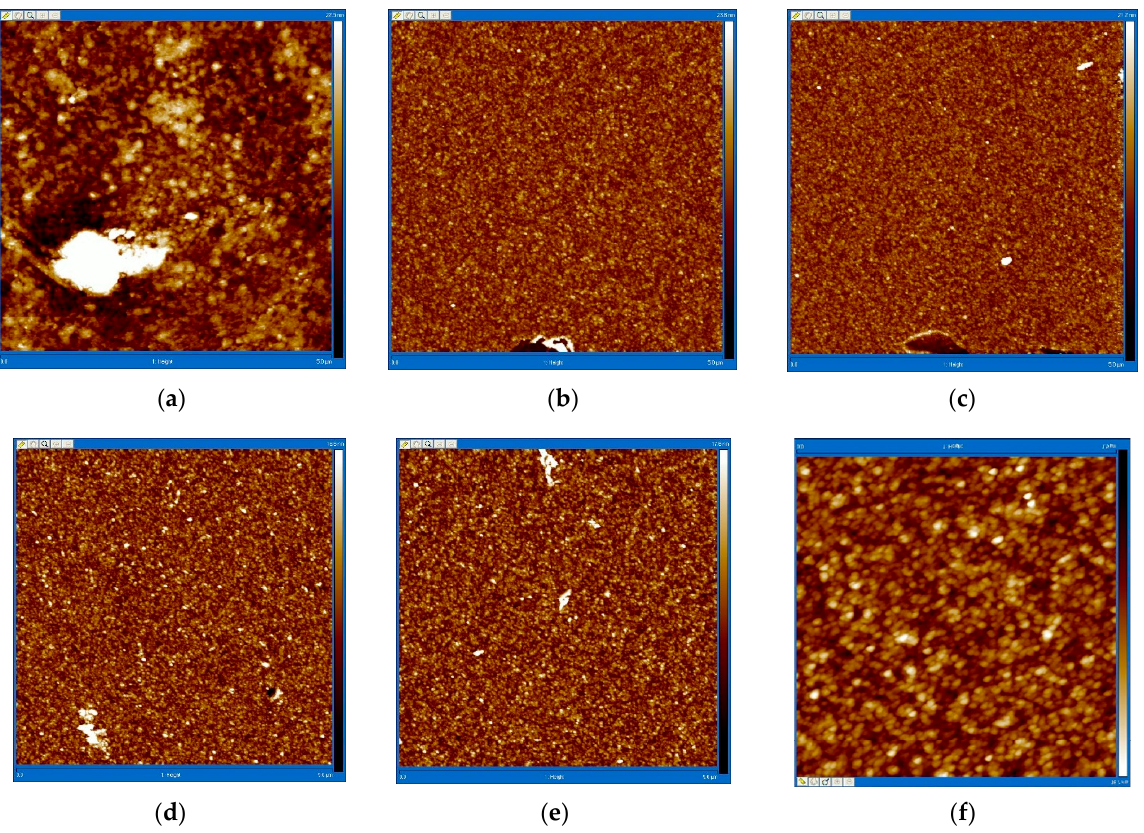
Figure 4. AFM-images of glass substrates at various stages of the silanization process: ( a )—untreated glass; ( b )—glass after washing (stage № 1); ( c )—glass after silanization (stage № 3); ( d )—glass after washing excess silane layers (stage № 5); ( e )—glass after annealing (stage № 7); ( f )—glass with deposited APTMS layer after processing with the dry film photoresist. ( a – e ): 5 µm × 5 µm; ( f ): 1.5 µm × 1.5 µm.